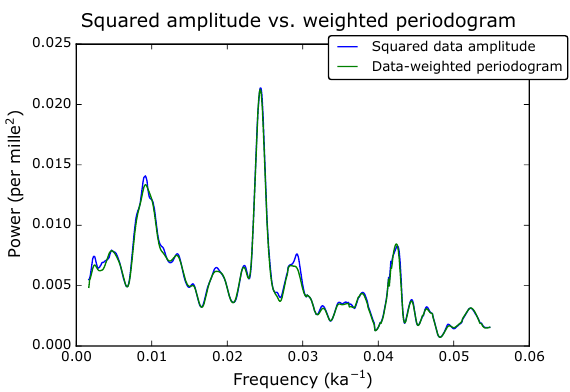
Figure 10. Comparison between the amplitude periodogram ( = squared amplitude) and the weighted periodogram. The green curve is the same as the black curve of Fig. 8c and